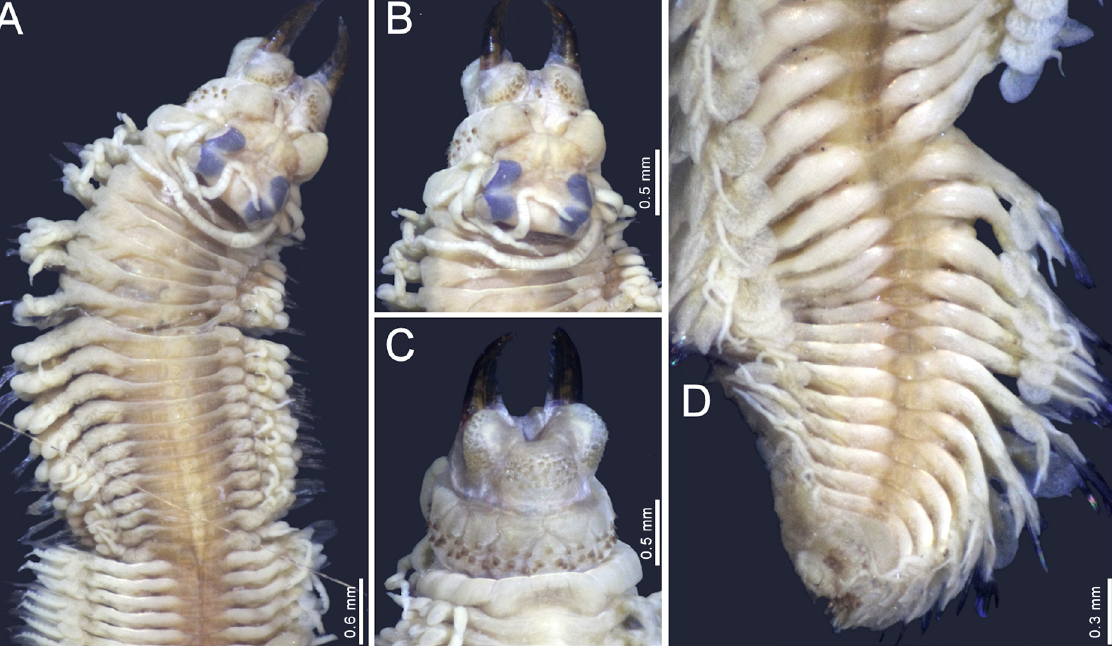
Fig. 3. Nereis splendida Grube, 1840, neotype (MNHN 423-311), male epitoke. A . Anterior region, dorsal view, depressed by cover slip. B . Anterior end, dorsal view. C . Anterior end, ventral view. D . Posterior region, dorsal